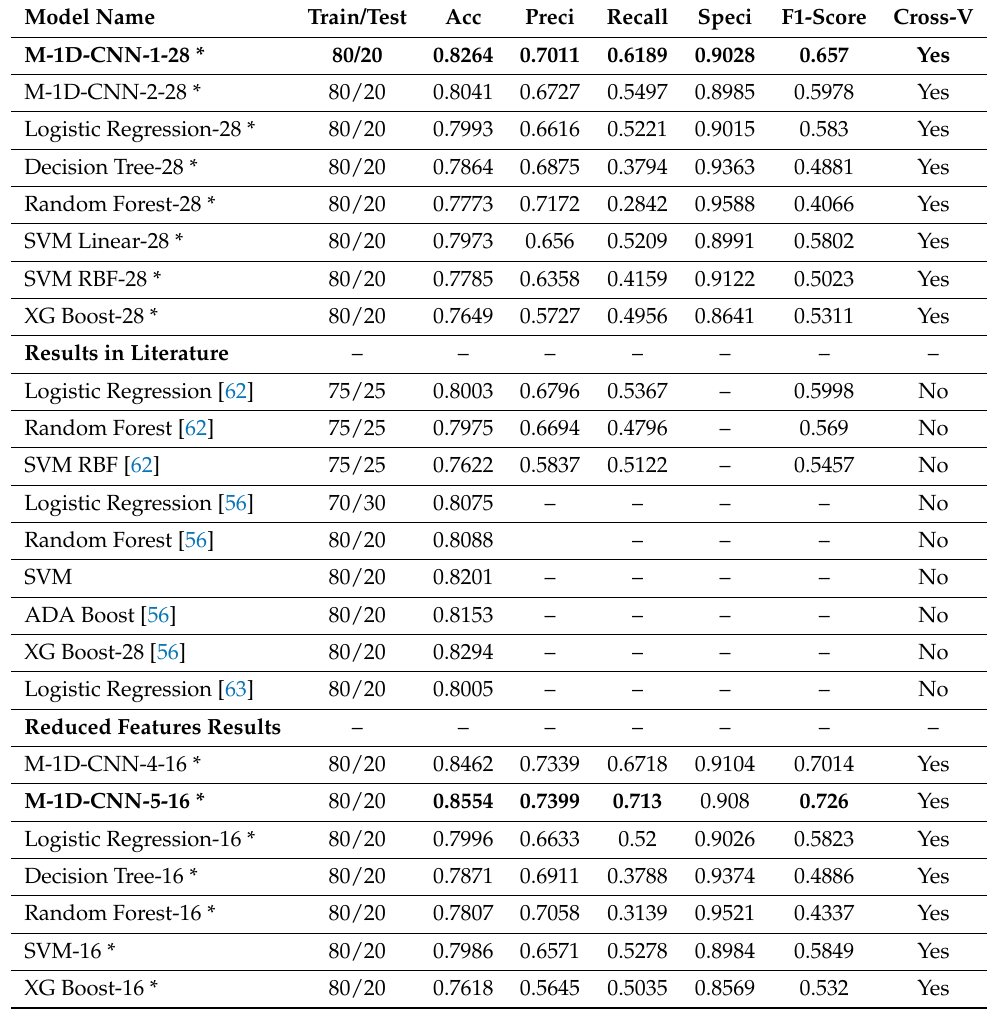
Table 3. Comparison of ours (with *) vs. other models on TCCDD. Accuracy, precision, specificity, and cross-validation are represented by Acc, Preci, Speci, and Cross-V,